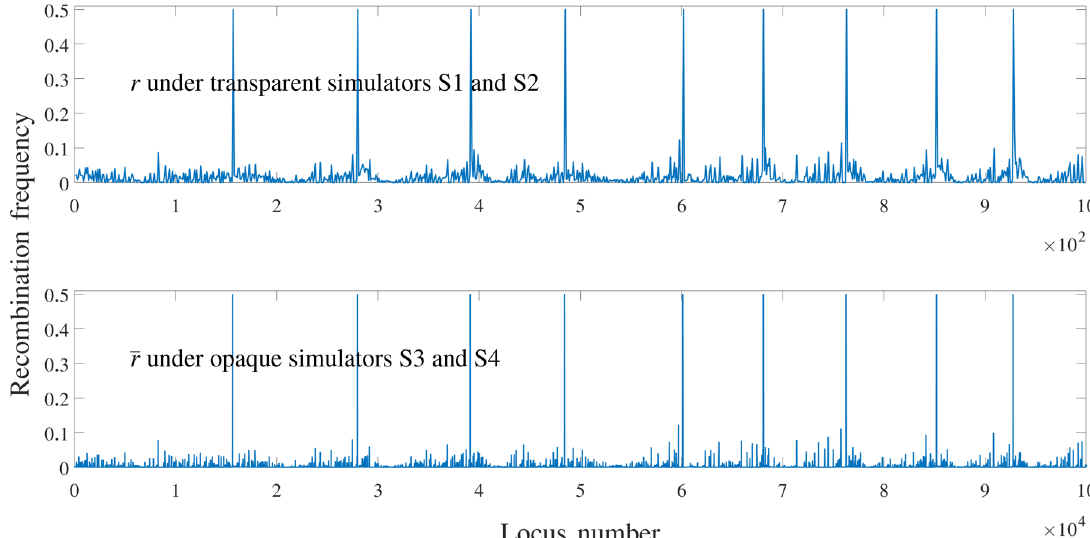
Figure 6. Assumed ground truth recombination frequencies in the four